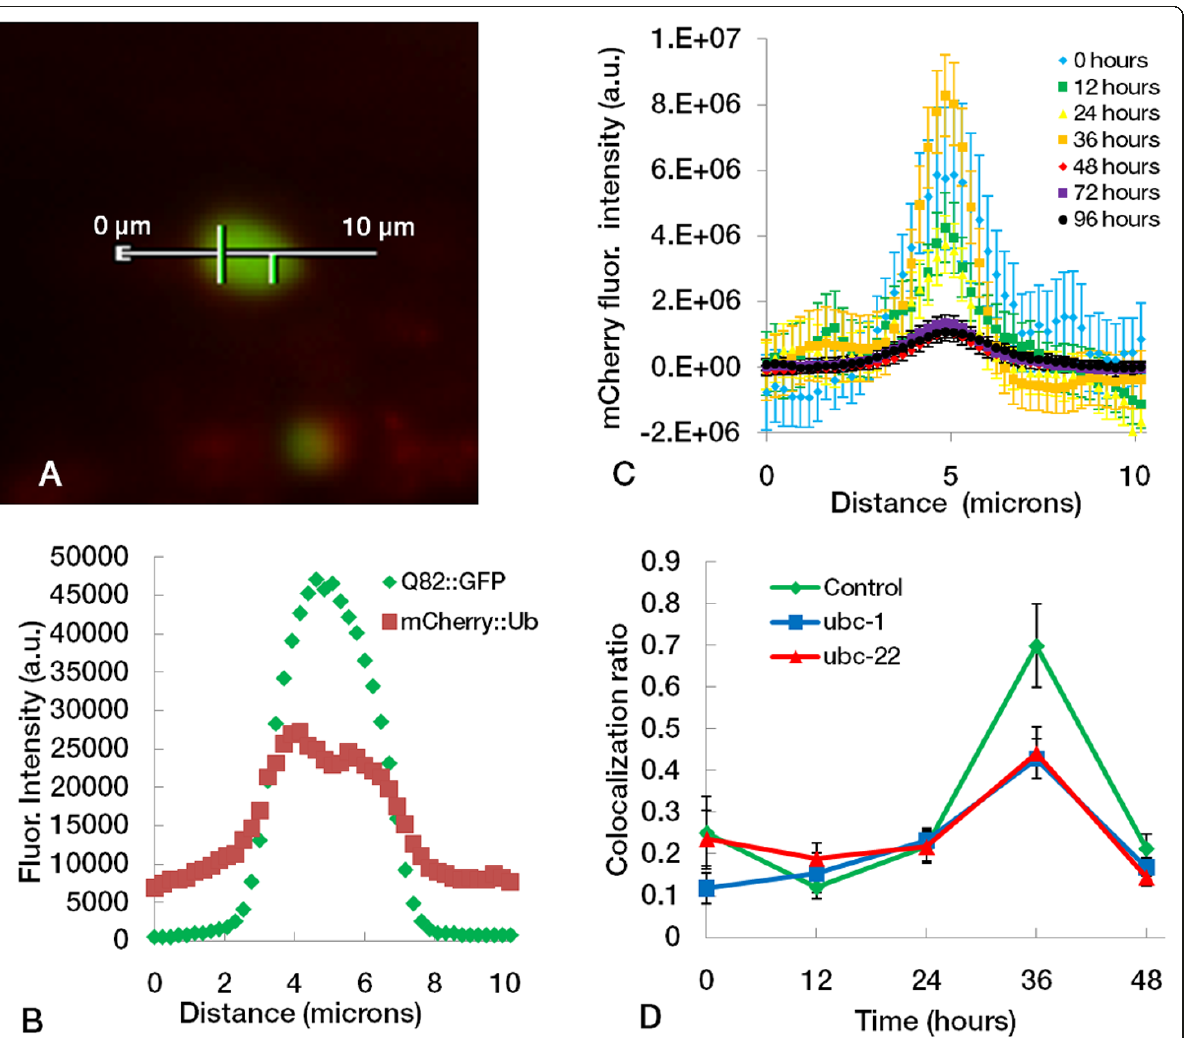
Figure 5 mCherry::ubiquitin colocalization to Q82::GFP aggregates . Worms co-expressing an mCherry::ubiquitin with Q82::GFP were exposed to RNAi of ubc-22, ubc-1 , or pL4440 control. A typical control aggregate is shown in ( A ) with a 10.16-micron line (45 pixels) measuring a cross- section of fluorescence intensity. Data for this line profile is shown in ( B ). ( C ) Averaged line profile data for mCherry::ubiquitin fluorescence of Q82::GFP aggregates at multiple time points. Higher levels of colocalization of mCherry::ubiqutin occur at an age of 36 hours. Peaks represent fluorescence values in the aggregates while the peripheral points represent intracellular fluorescence. Values are the mean (± SEM) of all values at that distance coordinate for aggregates at the given time point. All values have been normalized with respect to exposure time and background levels of fluorescence. ( D ) Time course of mCherry::ubiquitin colocalization to Q82::GFP aggregates shows the spike in ubiquitin colocalization at 36 hours, which is diminished by RNAi of ubc-1 or ubc-22 . Data shown are the mean (± SEM) ratio of mCherry fluorescence to GFP fluorescence from line profile measurements of composite images for multiple aggregates at each time